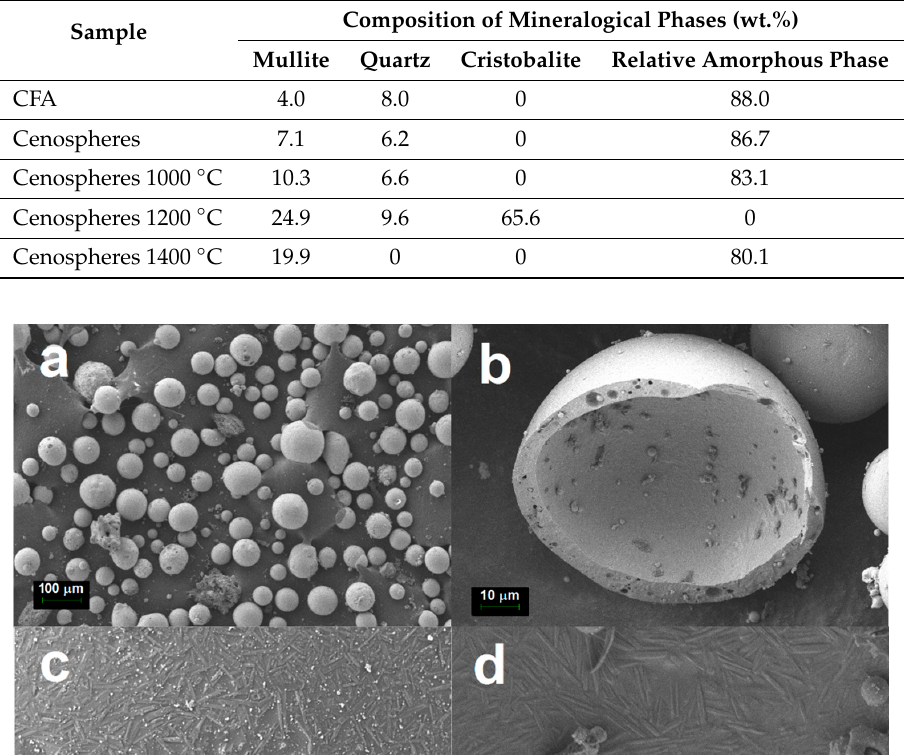
Figure 4. FESEM images of cenospheres heated at 1000 °C showing ( a ) size distribution of the cenospheres ( b ) single sphere and ( c ) outer surface of a sphere in closer view ( d ) agglomeration of cenospheres after sintering.